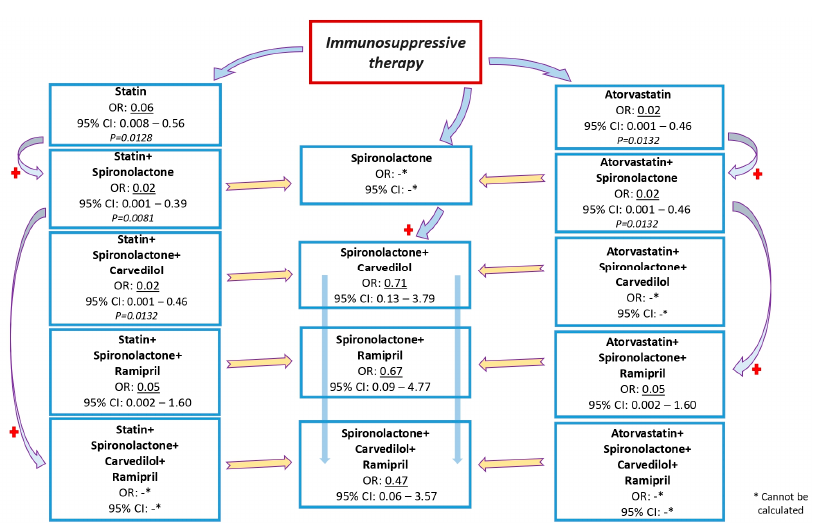
Figure A1. A schematic illustration of the associations between drug therapy and 2-month presence of postoperative complications of any cause.